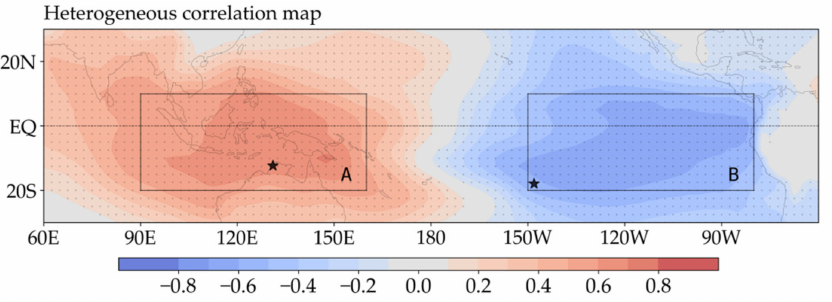
Figure 3. The correlation coefficients (shade) between the original SLP anomaly field and the time coefficient series corresponding to the singular value decomposition (SVD) first mode of the SST anomaly field during 1955–2020. The black solid box A and B are the key SLP regions selected in this study. The left and right asterisks show the locations of the Darwin and Tahiti stations, respectively. Light black dots indicate that the results pass the Student t -test with a confidence level of